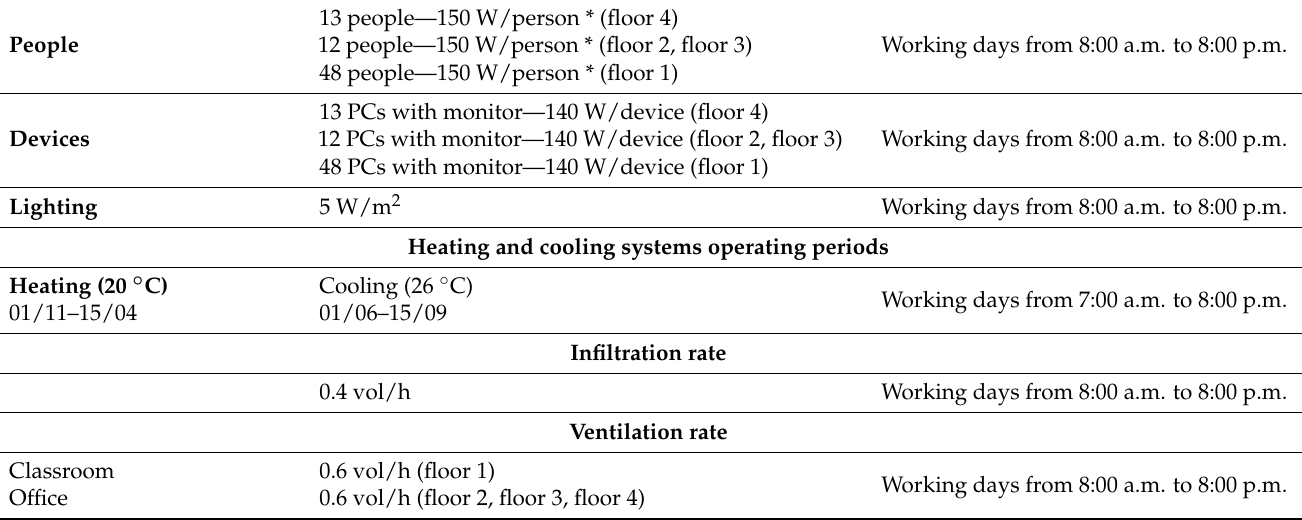
Table 3. Model simulation